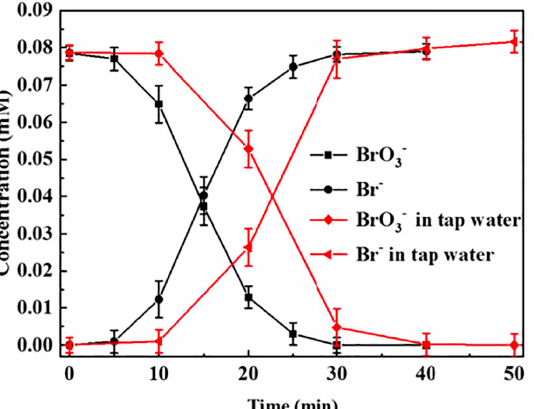
Figure 5. The bromate/bromide concentration changes in treated tap water and distilled water with initial bromate concentration of 0.078 mM over CoS 2 hollow spheres catalyst. Reprinted from [71], Copyright (2020), with permission from Elsevier.